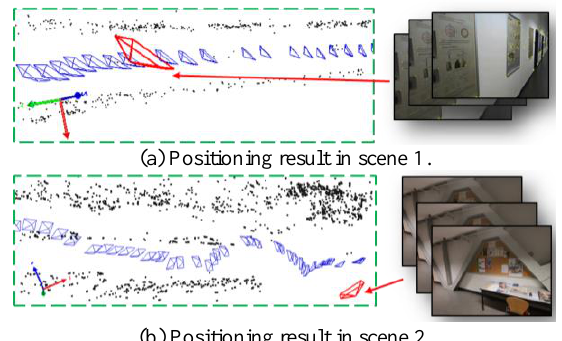
Figure 4. Examples of positioning results.